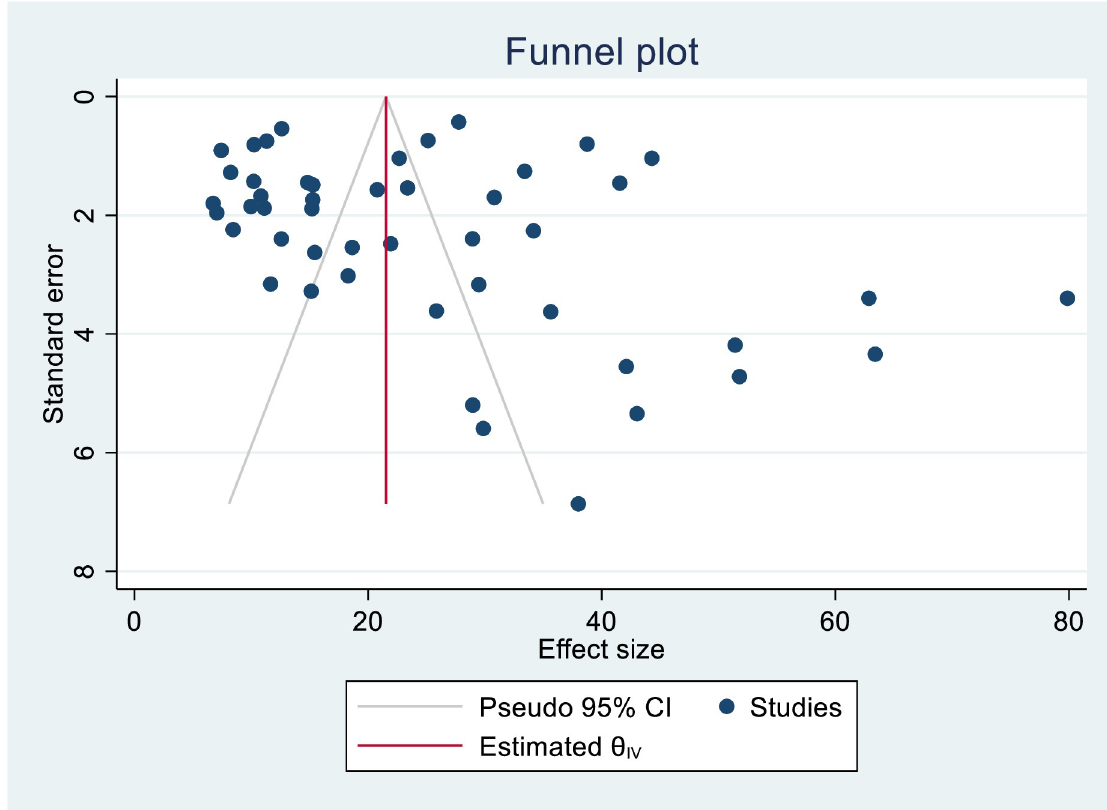
Fig 4. Funnel plot showing publication bias among studies used to compute the incidence of mortality in patients with drug-resistant tuberculosis.